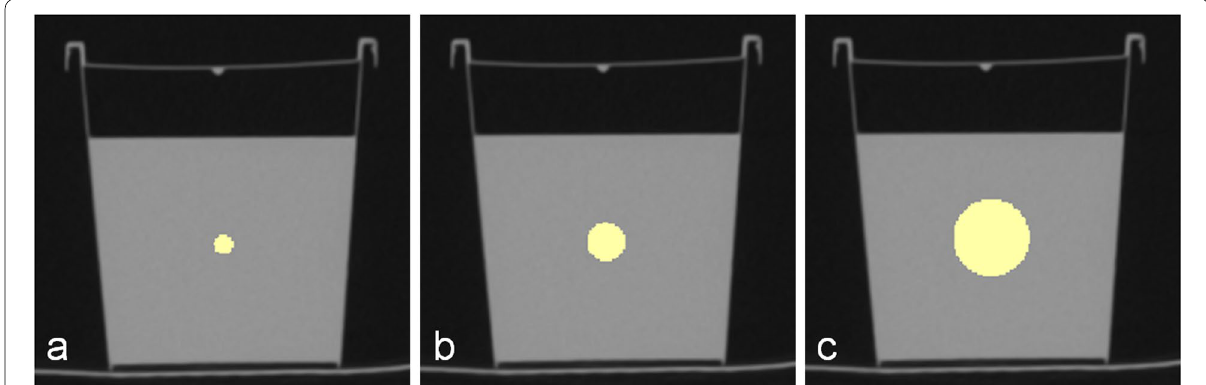
Fig. 1 Computed tomography images of the phantom and volume‑of‑interest (VOI) placement. Differently sized VOIs are drawn into the centre of the phantom. a shows a VOI with 4 mm in diameter, b with 8 mm, and c with 16